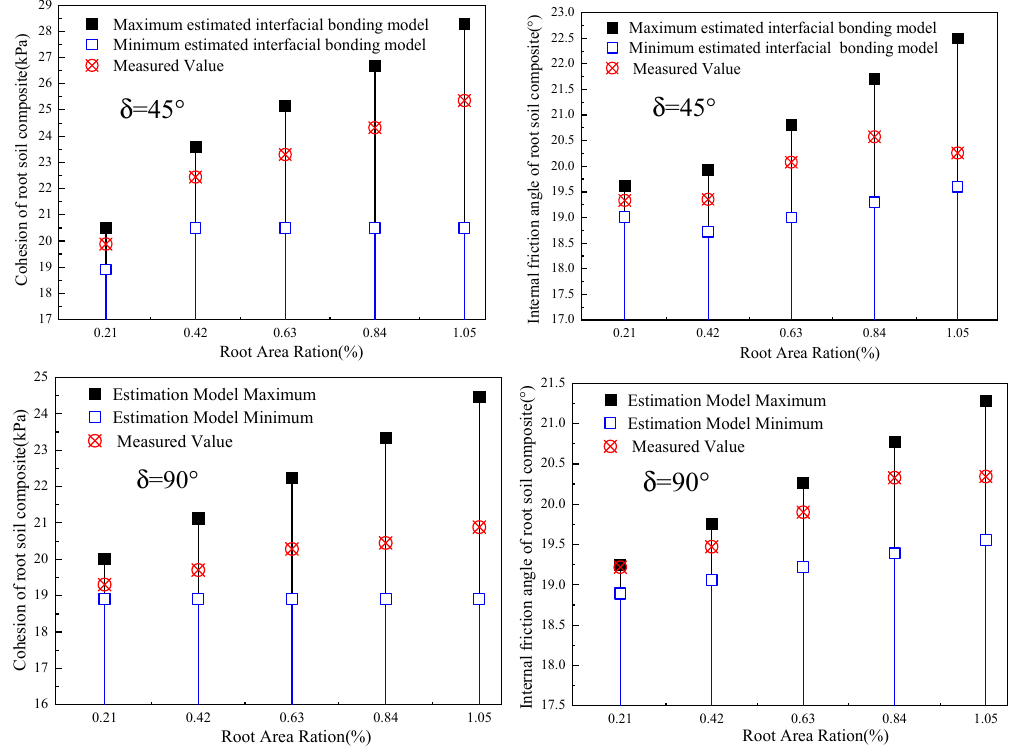
Figure 19. Comparison between measured values and calculated values of shear strength parameters of root-permeated soil.